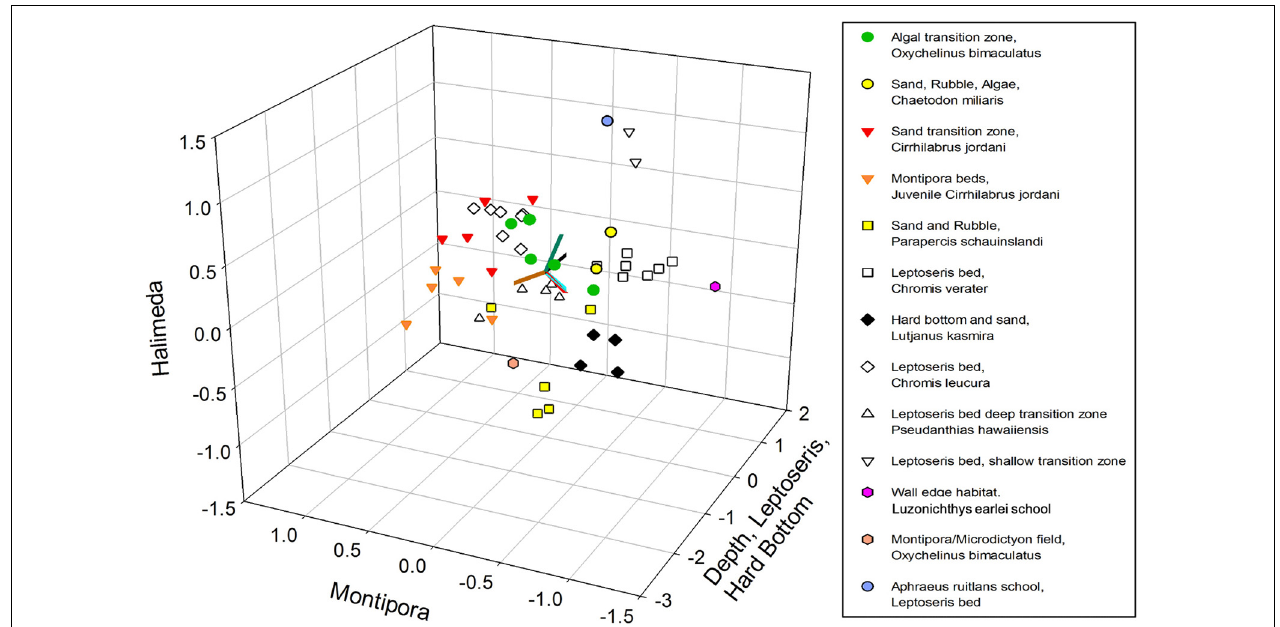
FIGURE 2 | Non-metric Multidimensional Scaling (NMDS) plot of fish species abundance and substrate categories. Samples are color-coded according to their hierarchical cluster membership. Environmental variables are shown using gradients in depth and four substrate types (Hard Bottom, Halimeda , Leptoseris, and Montipora ).